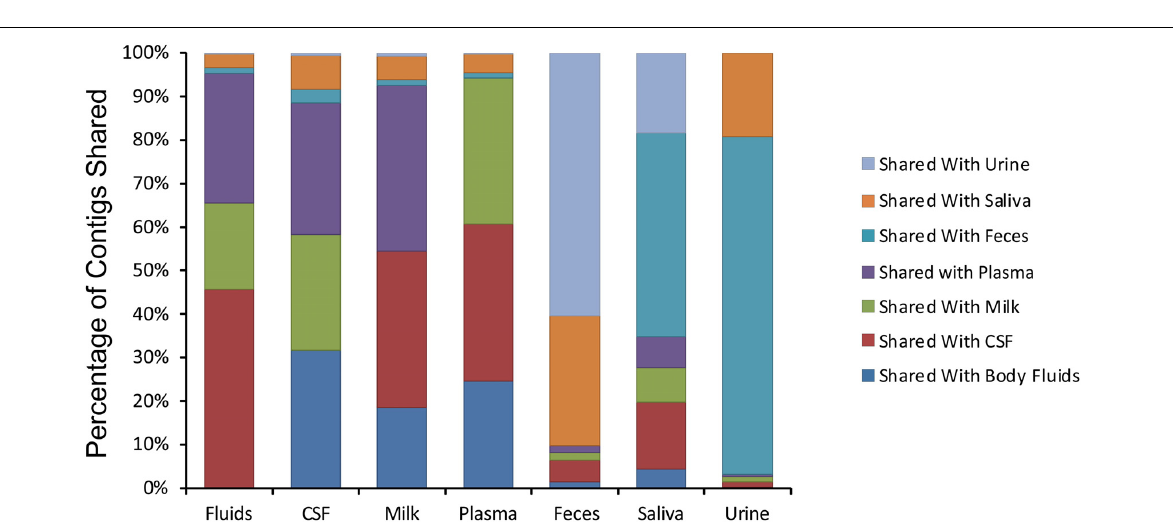
FIGURE 4 | Percentage of contigs that were used in the assembly of larger viruses from various human specimens. The y-axis represents the percentage of viruses assembled that contained contigs from various specimen types, and the x-axis represents each specimen type. For example approximately 45% of viruses assembled from body fluid viromes also contained contigs from cerebrospinal